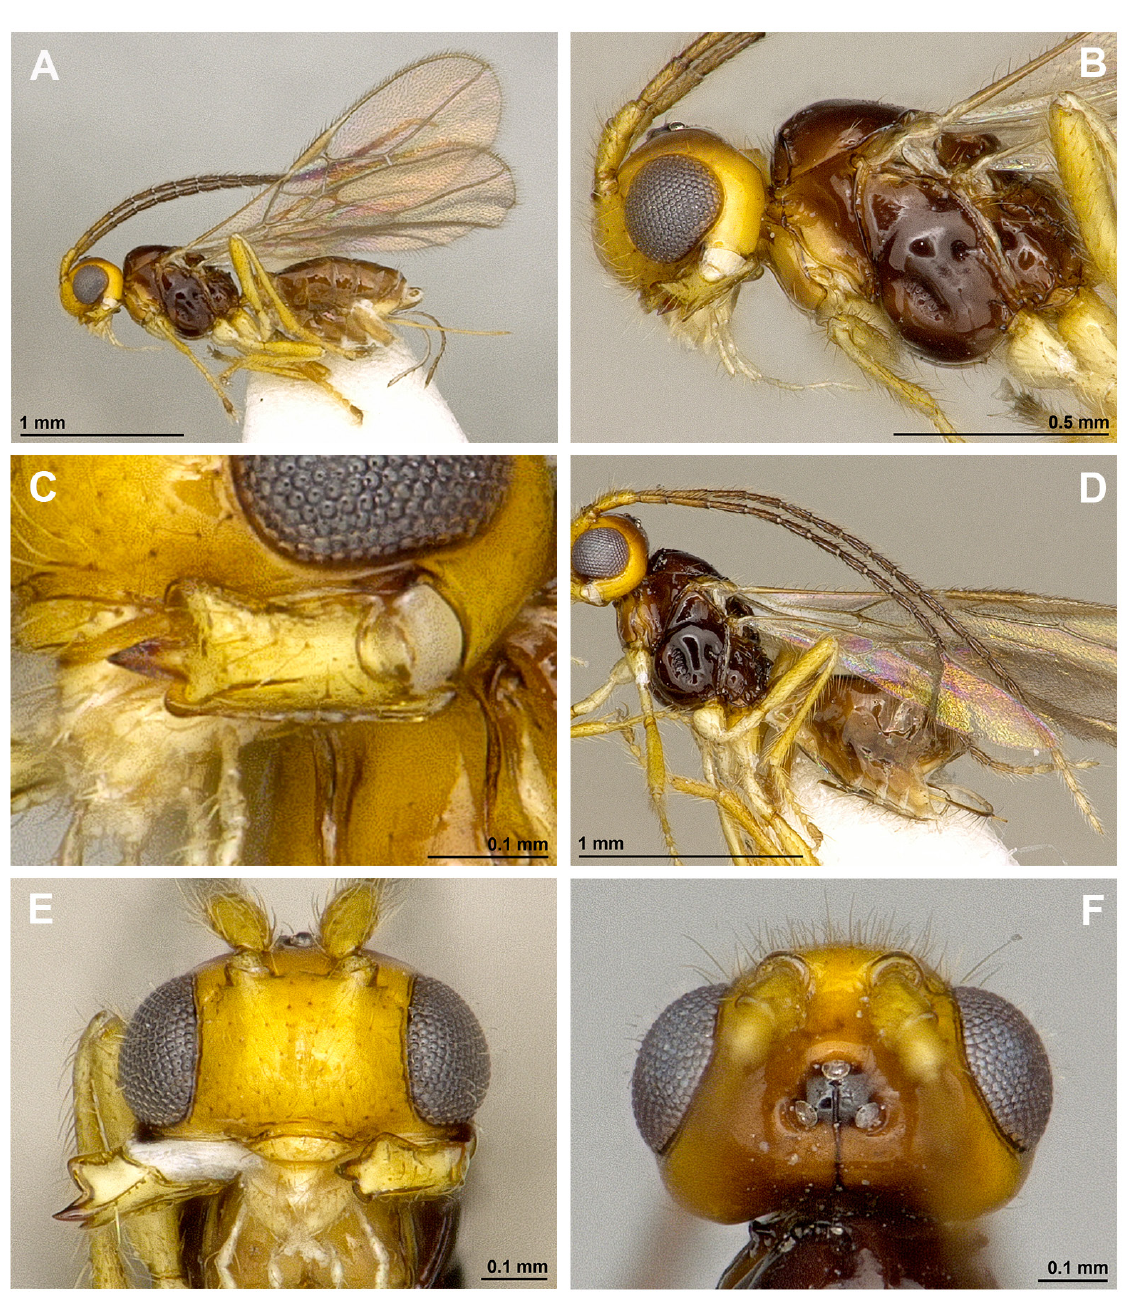
Fig. 41. Asobara mellicephalata van Achterberg, sp. nov., ♀, holotype (RMNH). A . Habitus, lateral view. B . Head and mesosoma, lateral view. C . Mandible. D . Antenna. E . Head, front view. F . Head, dorsal